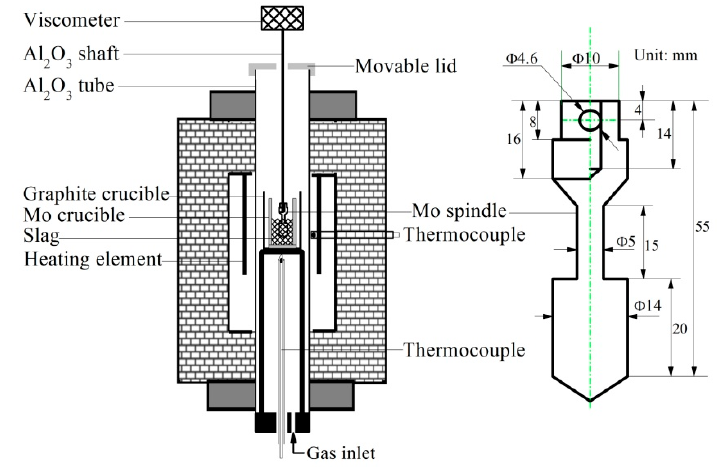
Figure 1. Experimental apparatus for viscosity measurement.